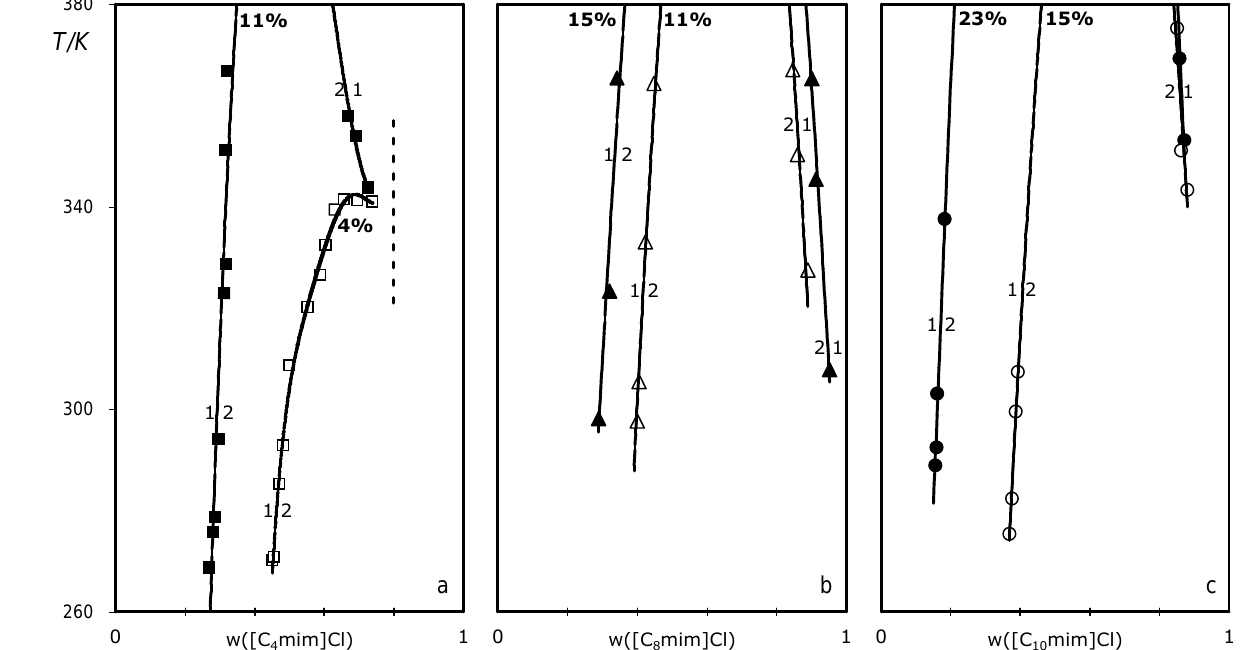
Figure 2. Cloud-point temperature as a function of ionic liquid concentration (weight fraction) in (K PO + [ C mim ]Cl + H O) solutions; (a), n =4; (b), n =8; and (c), n =10. In bold are the weight 3 4 n 2 percentages of K PO in the initial (K PO + H O) solutions. The 1 and 2 numerals on each side of the 3 4 3 4 2 solid lines represent the transition from a homogeneous to an aqueous biphasic system (ABS), PO starts to precipitate in the respectively. The dashed line marks the concentration at which K 3 4 systems containing [ C mim 4